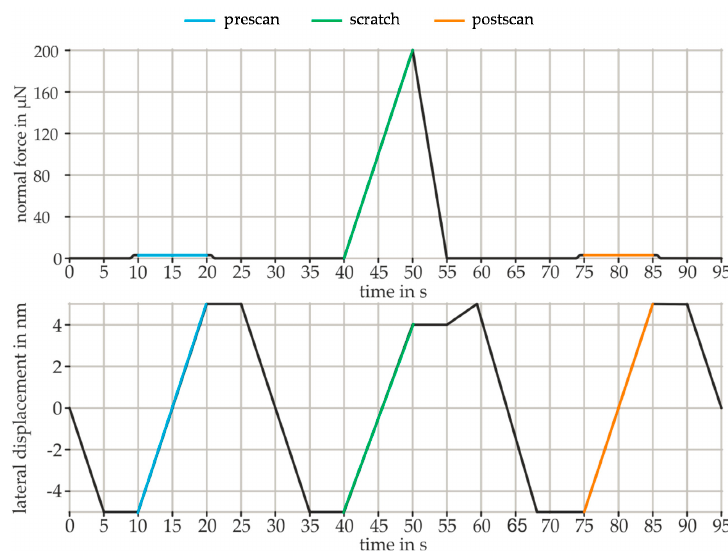
Figure 2. Chronological sequence of normal force and lateral displacement for the scratch test.